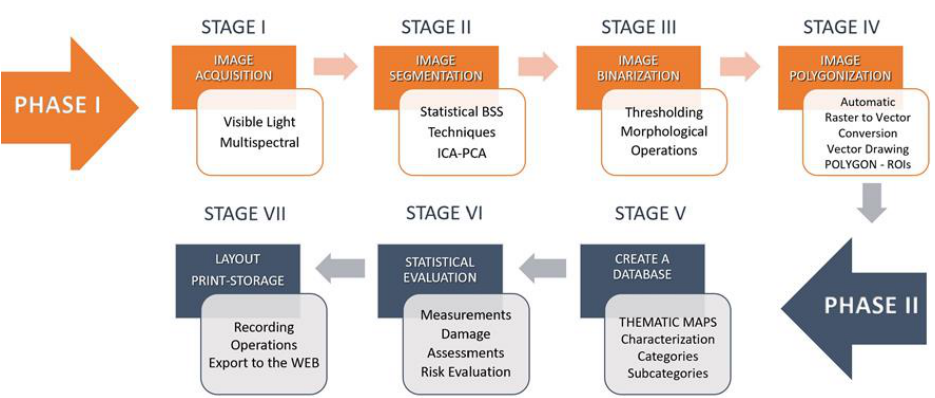
Figure 1. Methodology lifecycle.